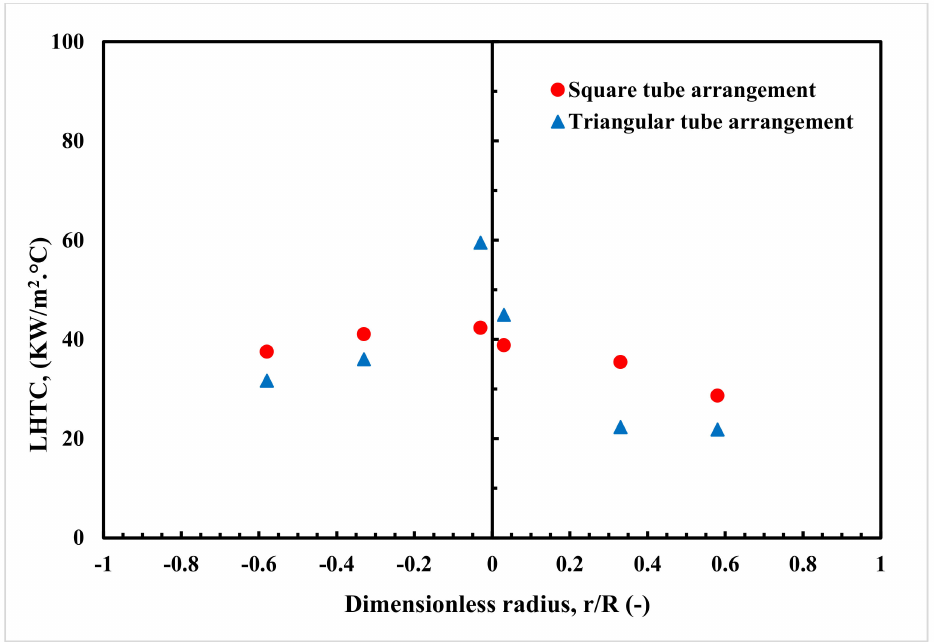
Figure 11. LHTC profiles measured at the axial level of 70 cm and an operating gas velocity of 0.45